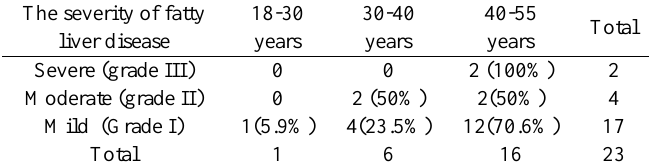
Table 3: Incidence of NAFLD in relation to age in obese